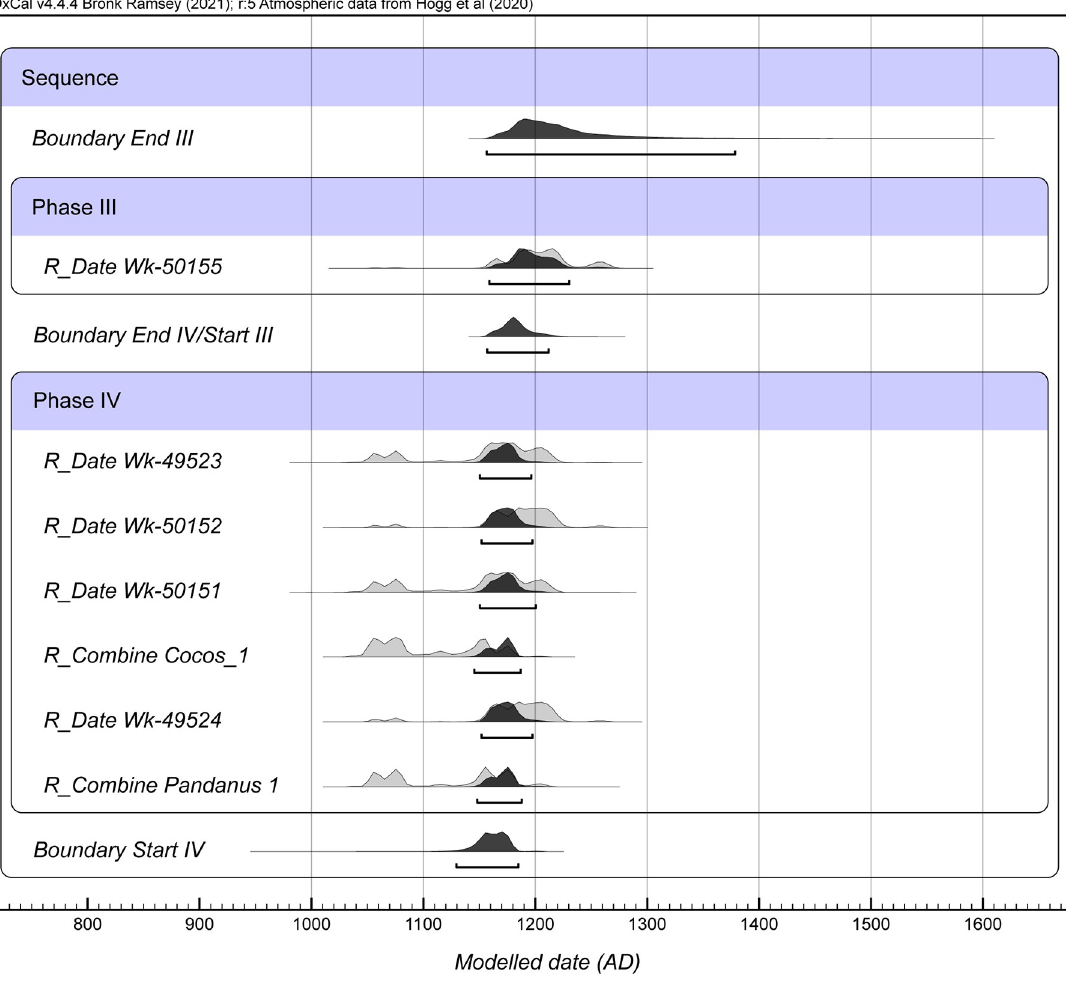
Fig 5. Bayesian age model for radiocarbon dates from Layers IV and III of Trench 1, Ho‘oumi Beach.